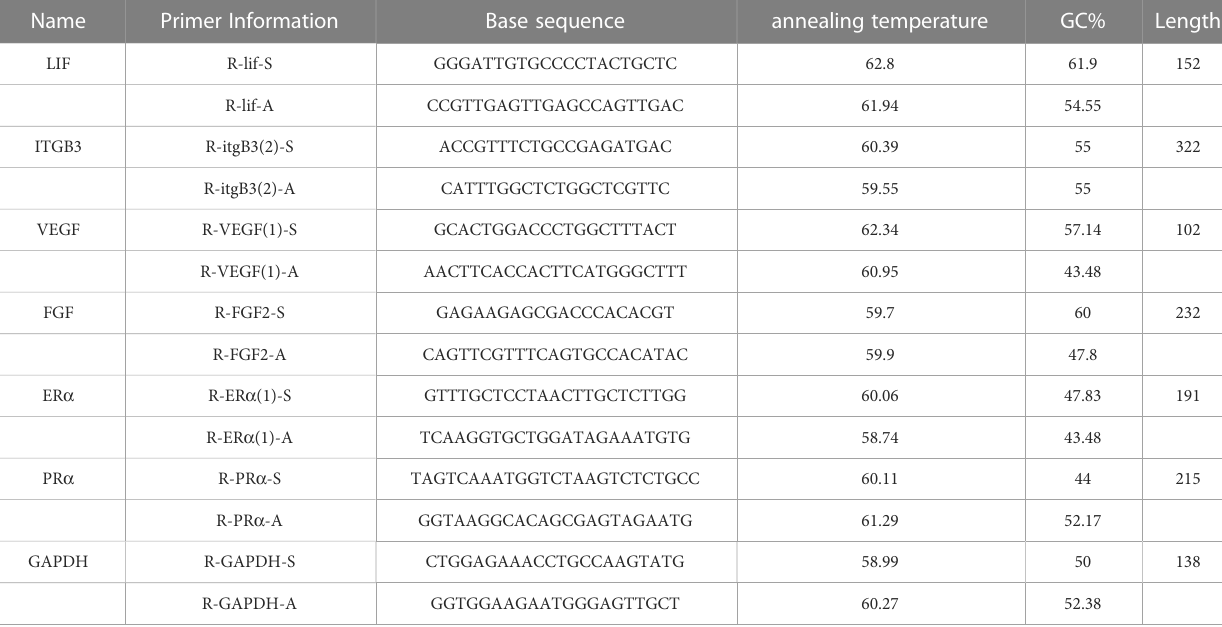
TABLE 1 Primer information of the LIF, ITG b 3, VEGF, FGF-2, ER a and PR a mRNA sequences.